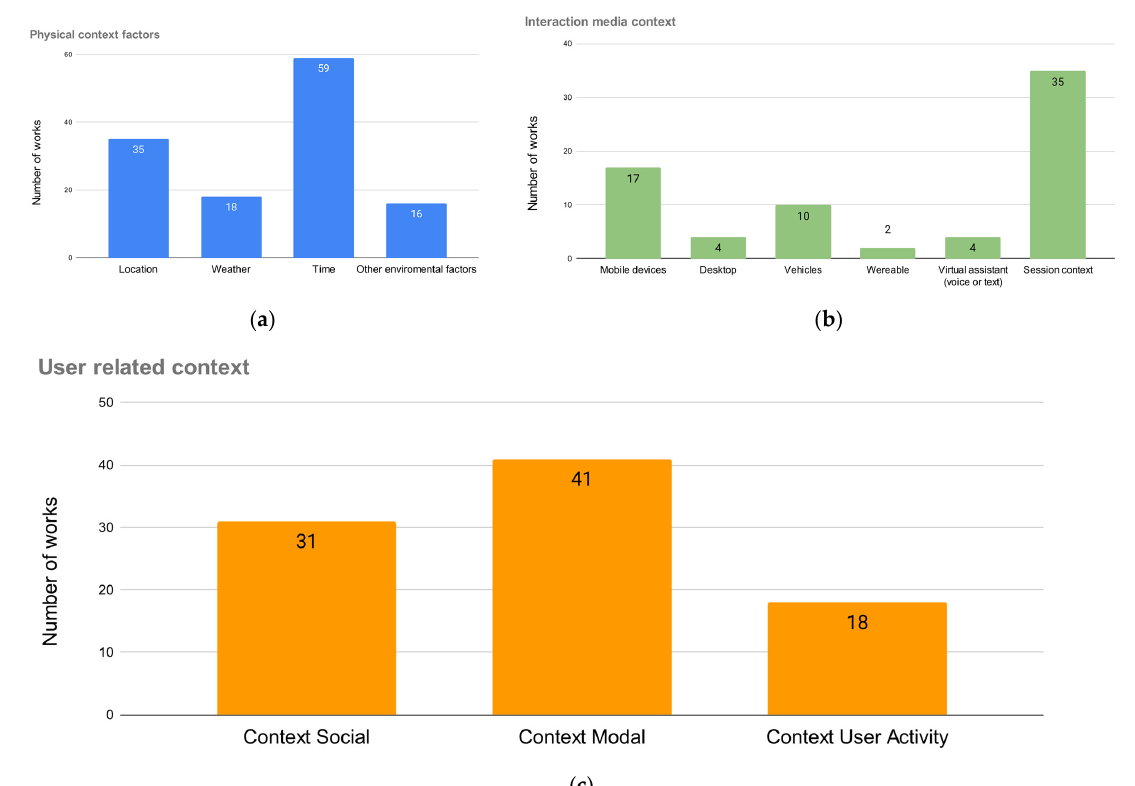
Figure 3. ( a ) Works employing physical context factors, ( b ) works employing different interaction media context ( c ) works involving user related context.